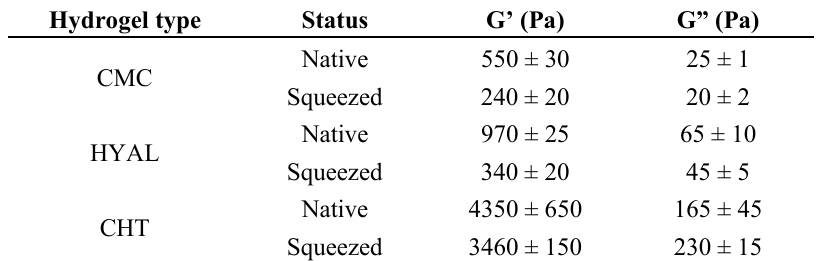
Table 1. Storage modulus (G’) and elastic modulus (G”) of polysaccharide hydrogels in native and after being squeezed. Data are reported as mean of three values  standard error.